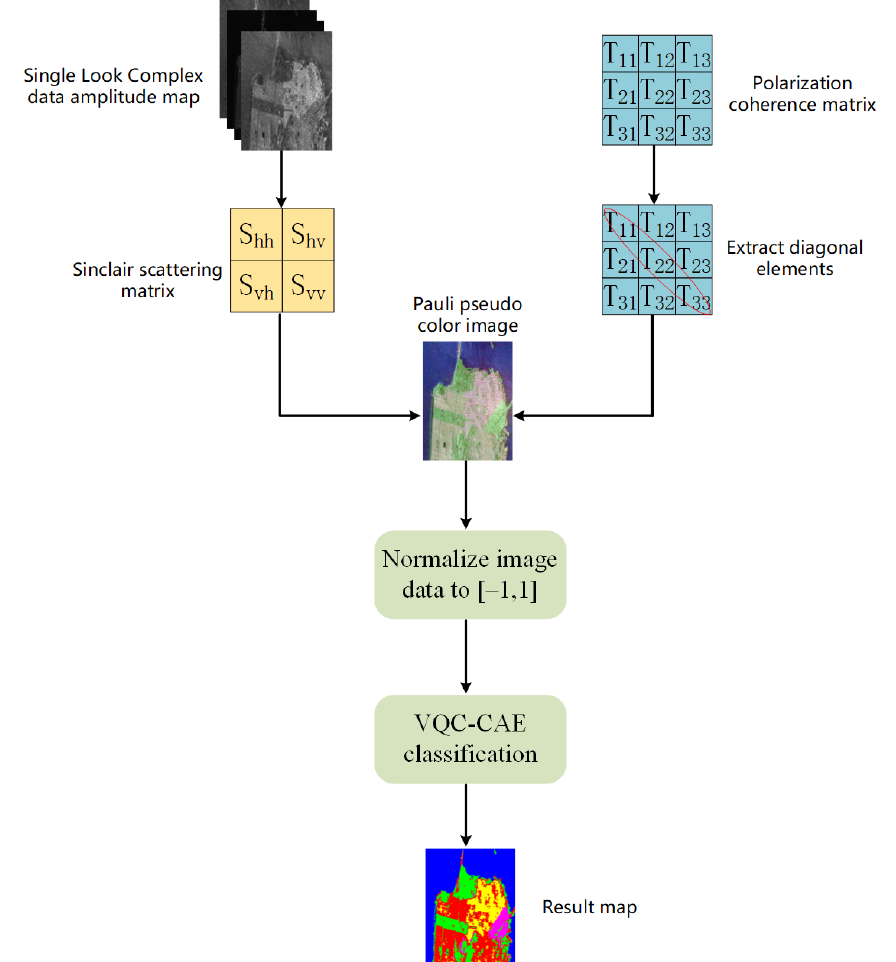
Figure 3. Flow chart of polarimetric SAR data preprocessing. There are two input sources: single look complex images and coherence